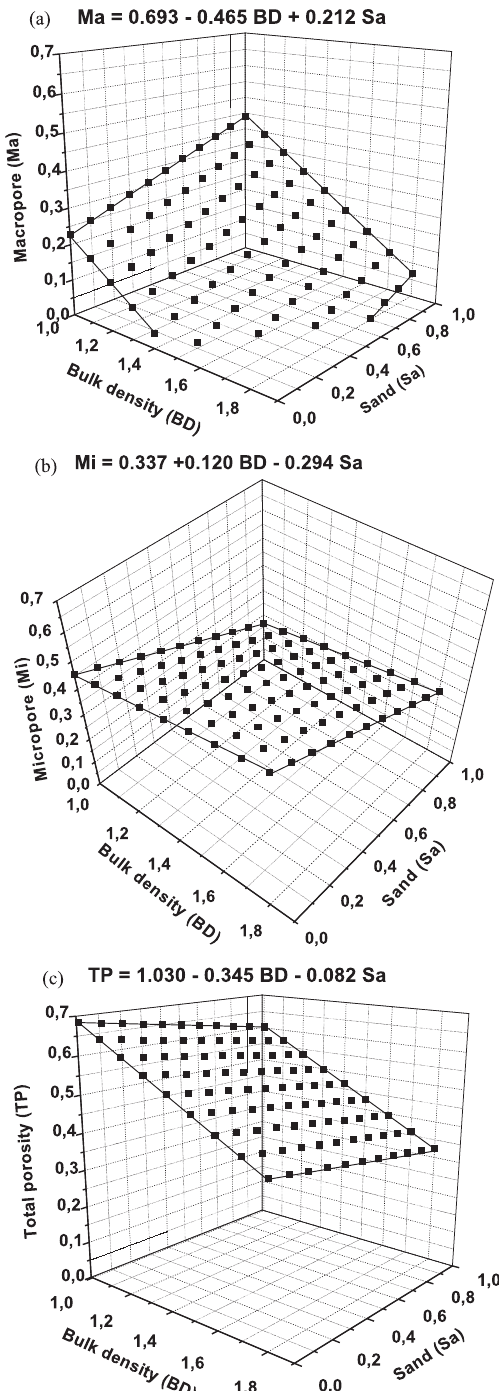
Figure 1. Three-dimensional representation of porosities according to model 2: (a) The strong variation in macroporosity is mainly related to soil bulk density and sand content.; (b) Microporosity varies mainly as function of sand content and less due to bulk density; (c): Total porosity varies mainly as a function of soil bulk density and less due to sand